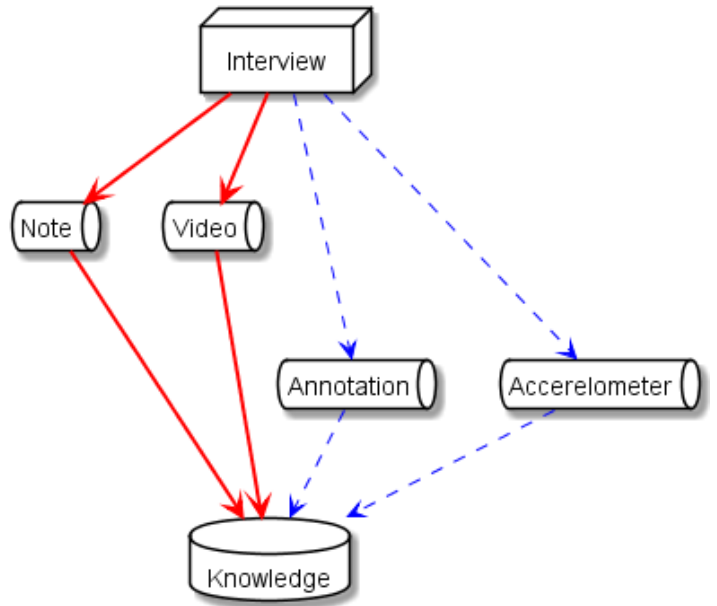
Figure 7. Reflection process through different analysis